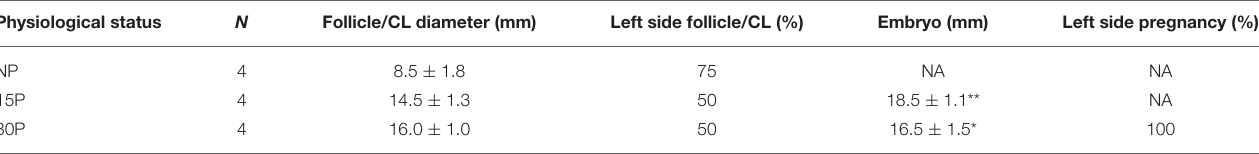
TABLE 1 | Reproductive features of alpaca’s experimental groups. Physiological status